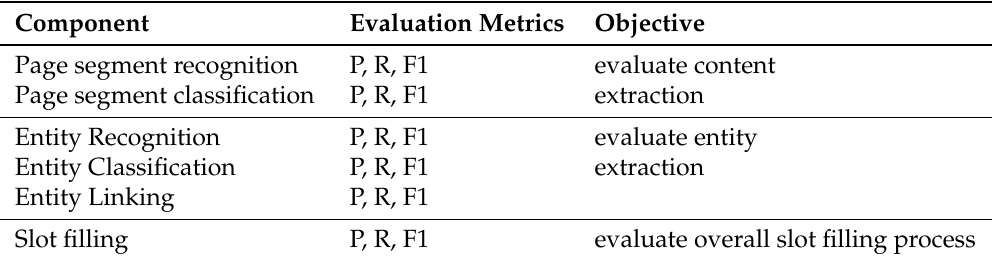
Table 4. Evaluation components, metrics, and objectives for the knowledge graph population population method (Section 4.1).